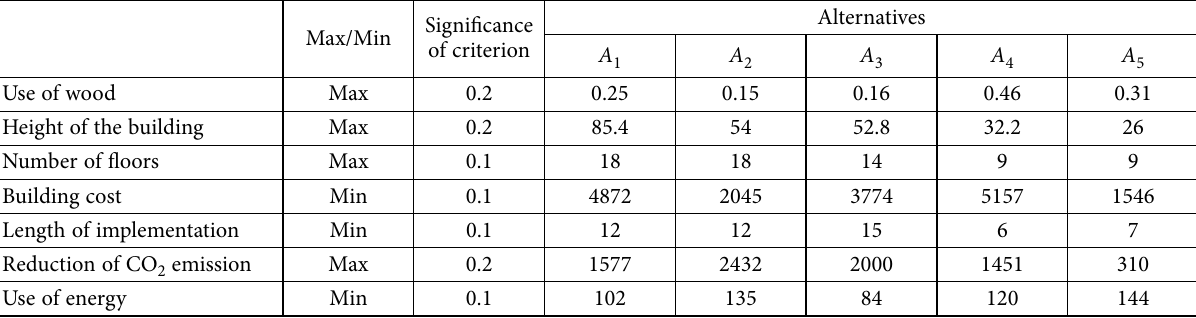
Table 2. Decision-making matrix